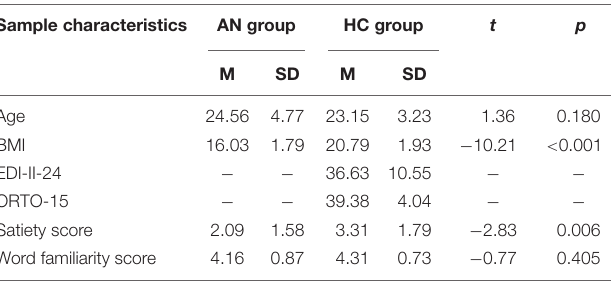
TABLE 1 | Study 1 participants’ characteristics by group and comparison of scores between groups. Sample characteristics